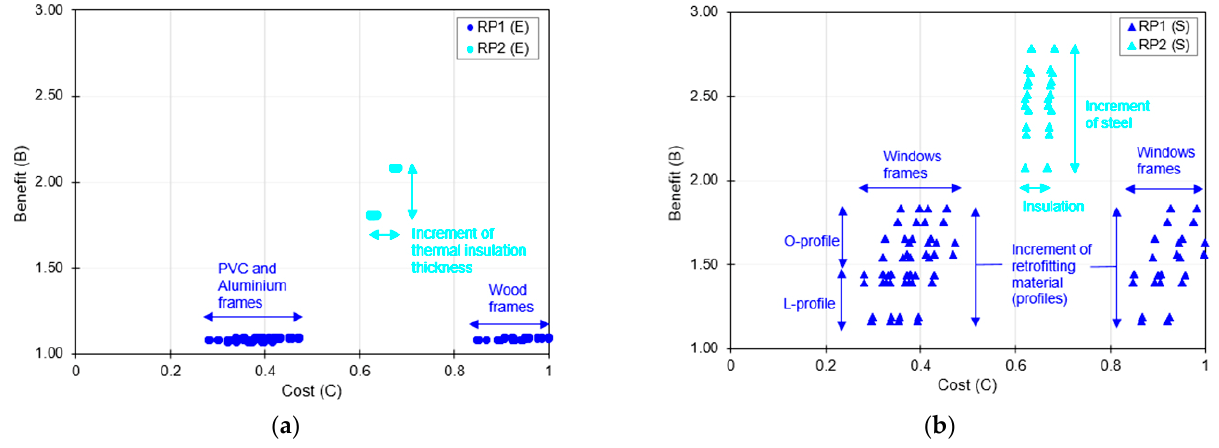
Figure 15. Energy ( a ) and seismic ( b ) performance ratios compared with the construction costs of each retrofitting configuration